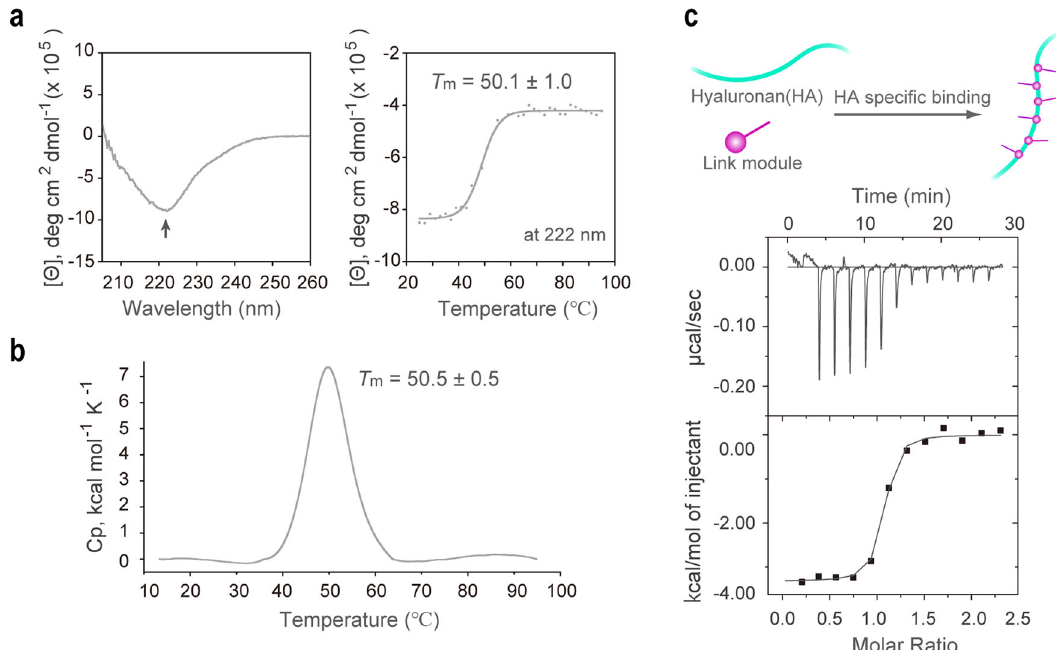
Fig. 2 Physicochemical properties of the puri fi ed LinkCFQ. a Representative curve of the circular dichroism spectra of LinkCFQ. A negative peak at 222 nm (arrow) indicated the presence of an α -helix structure. T m was determined to be 50.1 °C ± 1.0 °C based on sigmoidal curve fi tting using Eq. 1. The T m value was expressed as means ± standard deviations (SDs). b Representative curve of the thermal stability of LinkCFQ measured via differential scanning calorimetry. T m was determined to be 50.5 °C ± 0.5 °C (expressed as means ± SDs). c Representative curve of calorimetric titration of LinkCFQ (15 μ M) with HA (octasaccharide unit concentration, 150 μ M). Data were fi tted to the one-site binding model.